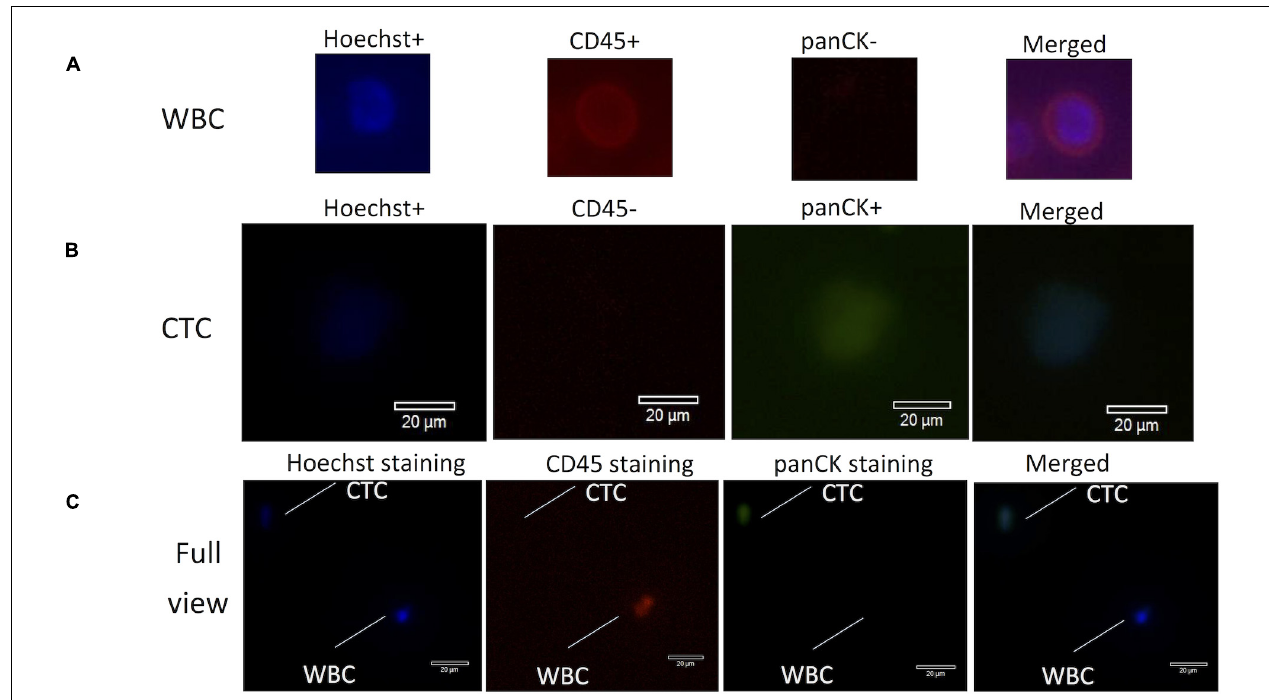
FIGURE 1 | Fluorescence images for identification of CTCs and WBCs stained with antibodies from lung cancer patients. (A) WBCs were stained with Hoechst (blue), CD45+ (red), panCK– (dark), and merged images of three-antibody staining. (B) CTCs were stained with Hoechst (blue), CD45– (dark), panCK+ (green), and merged images of three-antibody staining. (C) Optical images (60 × magnification) of isolated CTCs and WBCs under the microscope. Scale bar is 20 mm. CTC morphology is characterized by green fluorescence staining by panCK and nuclear blue staining by Hoechst but negative staining by CD45. CTCs, circulating tumor cells; WBCs, white blood